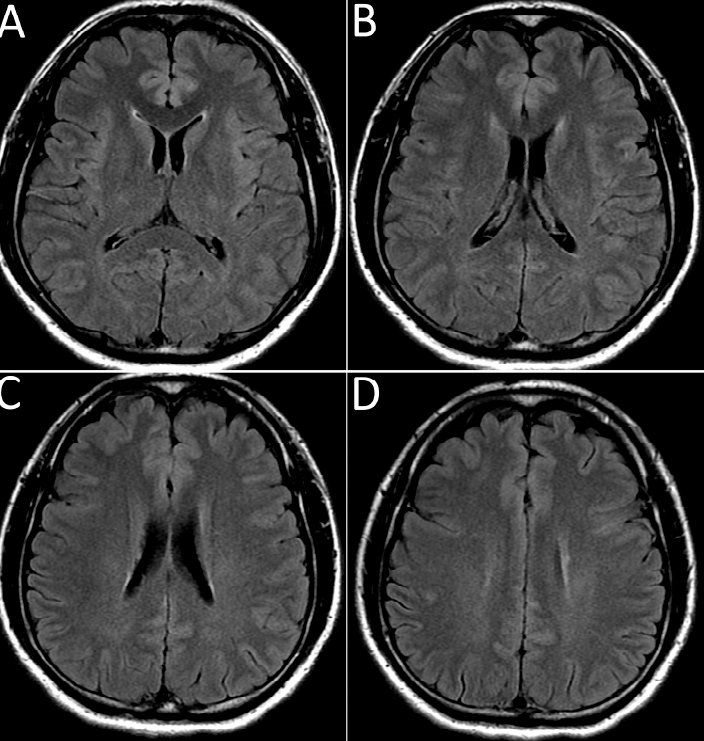
Figure 2. The serial axial MRI ( A – D ) of the brain on T2-weighted fluid-attenuated inversion recovery images showed no multiple sclerosis lesion in the periventricular area.